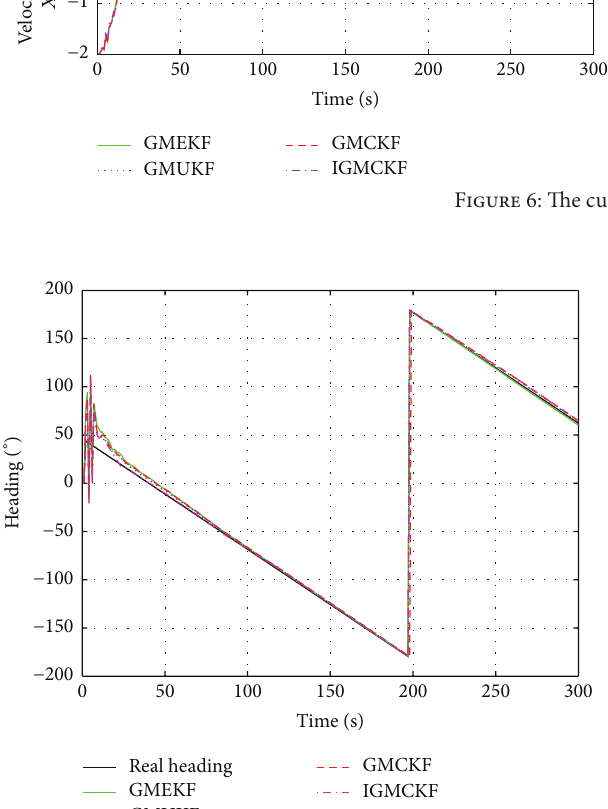
Figure 8: Comparison of the trajectory